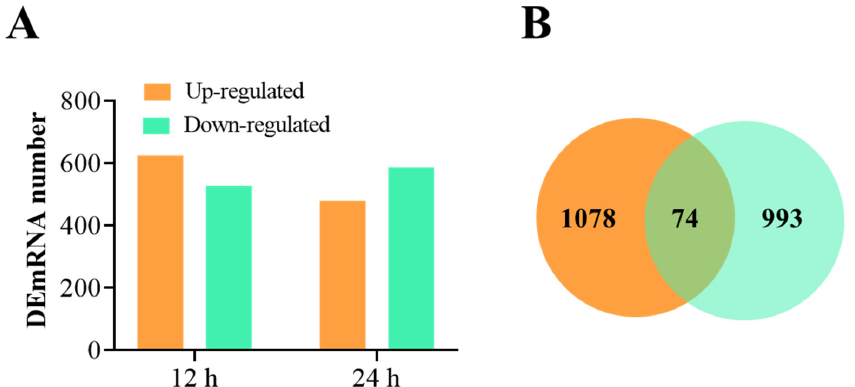
Figure 2. Overview of the RNA-seq data. ( A ) The number of mRNAs differentially expressed in the spleens of L. crocea challenged with P. plecoglossicida as compared to the control at 12 h and 24 h after injection . ( B ) Venn diagram showing the unique and shared DEmRNAs at 12 h (orange) and 24 h (green) after injection.